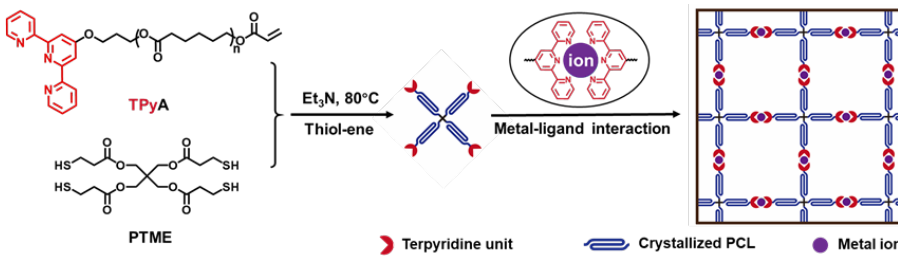
Figure 1. Process of constructing the metallo-supramolecular shape-memory network.